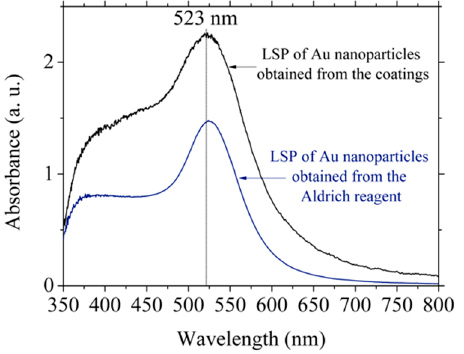
Figure 8. Absorption spectra of Au nanoparticles obtained from the coatings (black line) and from Aldrich’s reagent (blue line).